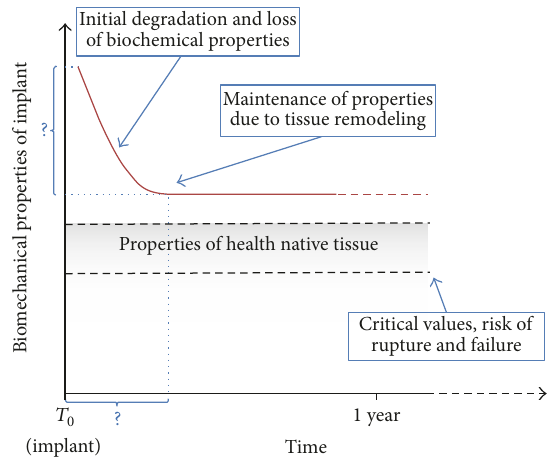
Figure 1: Ideal biomechanical properties of biodegradable scaffolds (adapted from Osman et al. [24]).